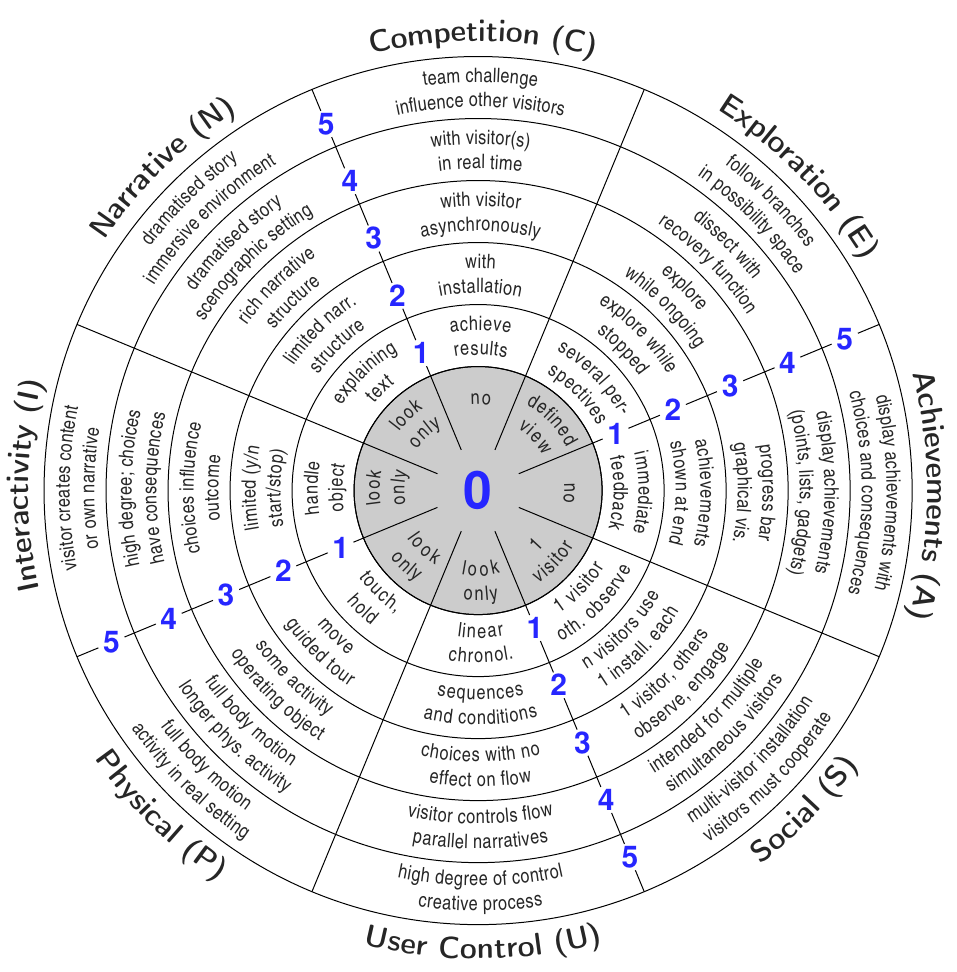
Figure 1. The dimensions of the Engagement Profile explained with short definitions. To define the value of a property, find the adjacent number of the phrases that fit